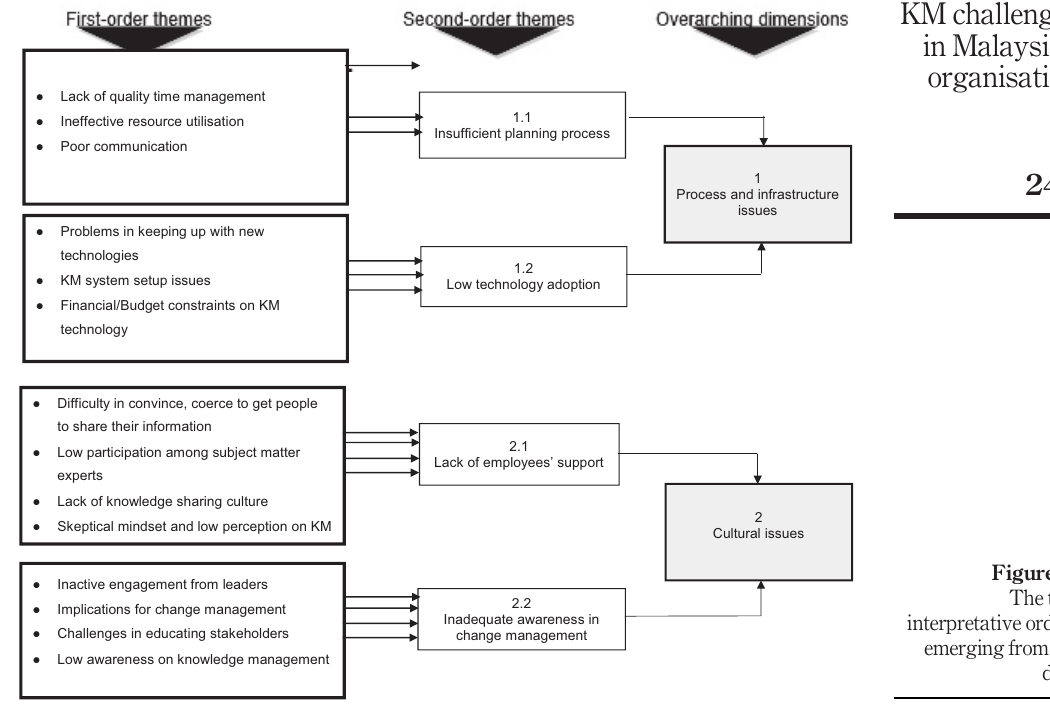
Figure 1. The two interpretative orders emerging from the